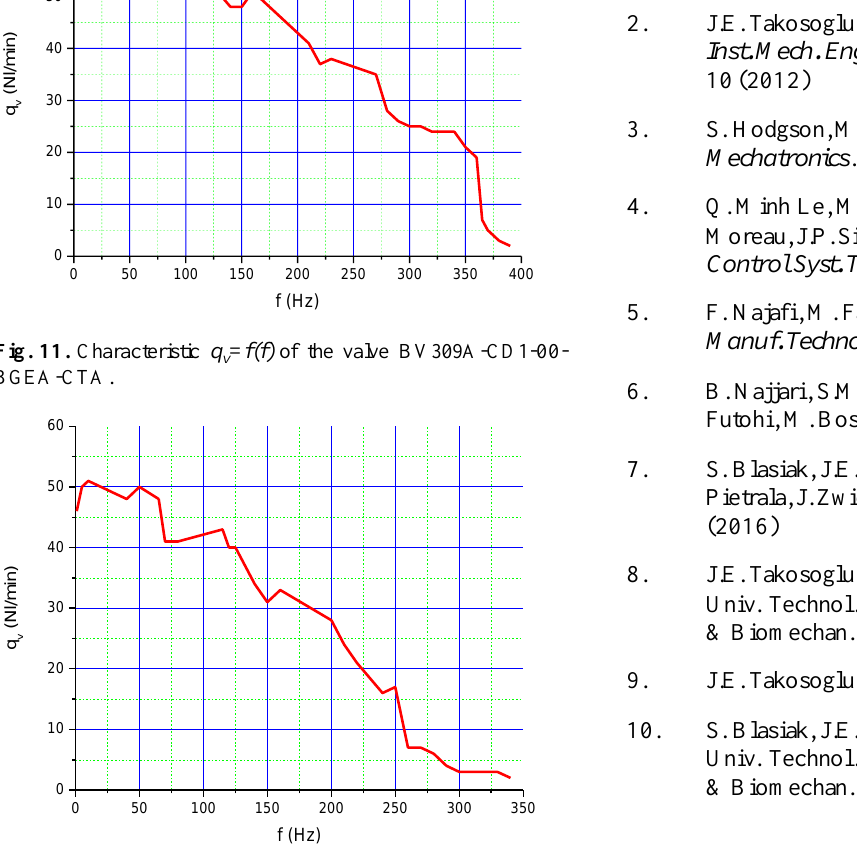
=f(f) of the valve BV310A-CD1-00- v